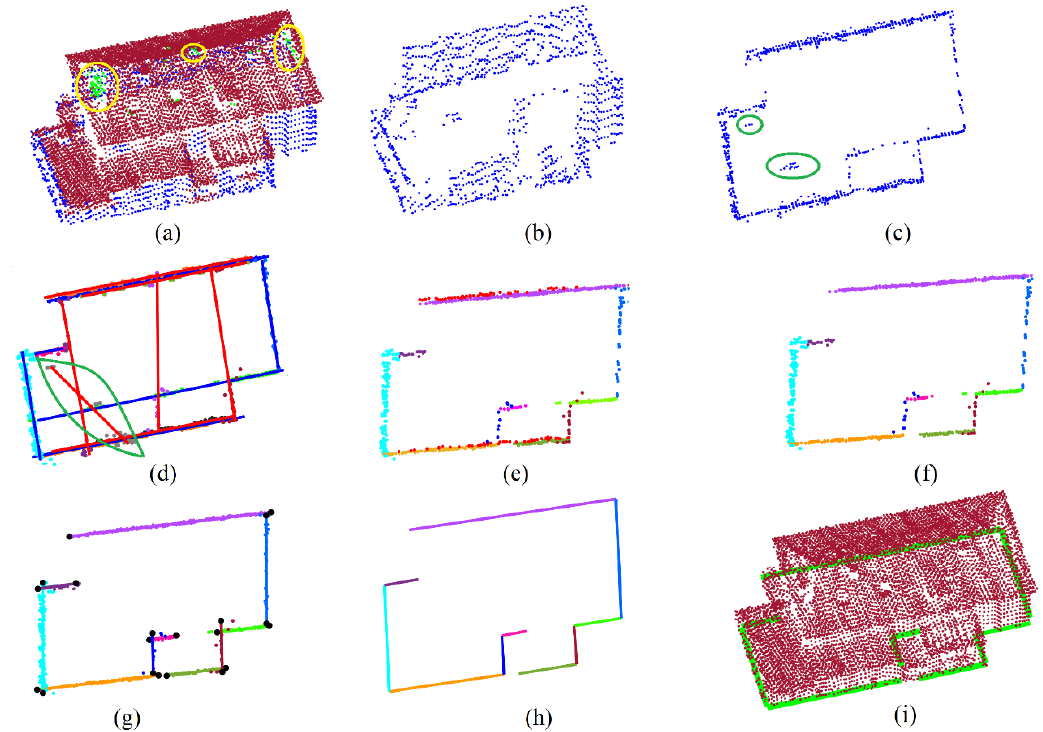
Figure 4. Building footprint extraction for the Dudelange data set: (a) classification of vertical (blue) and non-vertical (maroon) surfaces, vertical points within yellow ellipses are over the roof; where 𝜃 > 70 0 , (b) vertical surfaces (facades) below the roof, (c) 2D ( x , y ) points for the facades, (d) extracted lines using MSAC, (e) spatial segmentation for the 2D facades points; E d = 2m, (f) elimination of the redundant lines; using 𝐴 𝑡 = 5 0 , n PT=10, (g) LTS regression lines, (h) footprint-lines for the building, and (i) footprint (green)- lines aligned with the 3D building’s ground-truth.